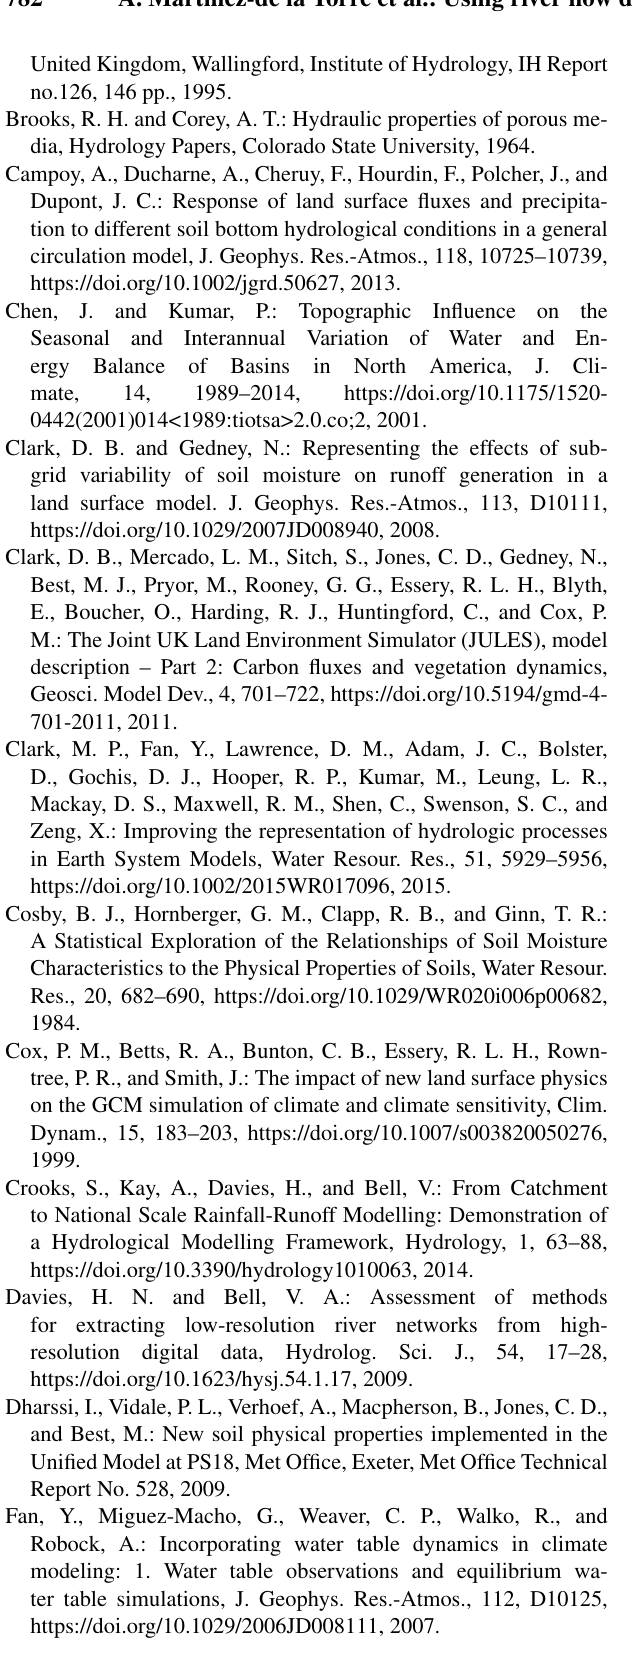
ter table simulations, J. Geophys. Res.-Atmos., 112,